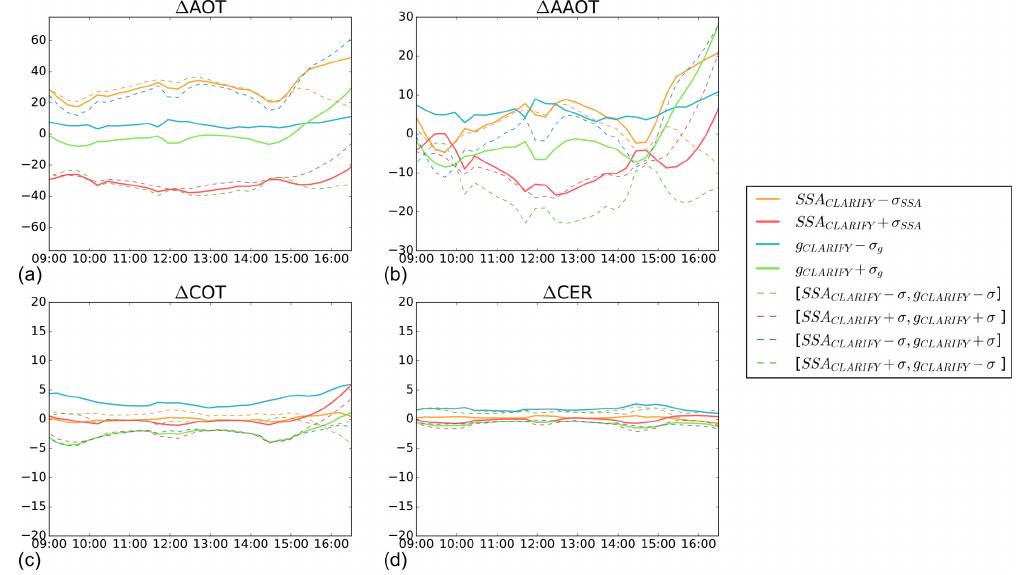
Figure 11. Time series (UTC) of the difference (cid:49) (%) of the above-cloud AOT (a) , AAOT (b) , COT (c) and CER (d) retrieved with the CLARIFY model and the modified aerosol models for 28 August 2017.